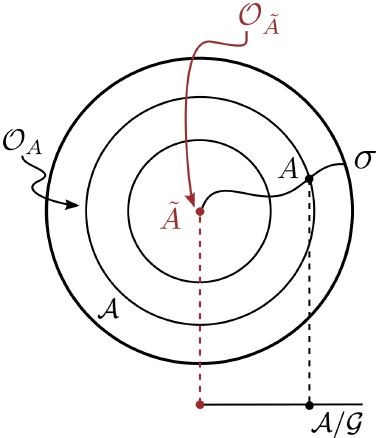
Figure 5: In this representation A is the page’s plane and the orbits are given by concentric circles. The field A is generic, and has a generic orbit, O . The field ˜ A has A a nontrivial stabilizer group (i.e. it has non-trivial reducibility parameters), and its is of a different dimension than O . The projection of ˜ A on A / G therefore orbit O ˜ A A sits at a qualitatively different point than that of A (a lower-dimensional stratum of A / G ). Exclusion of the reducible configuration ˜ A gives rise to a fibre bundle structure over A \ { ˜ A } ; here σ represents a section of A \ { ˜ A } . Locally, the concept of section can be generalized to include reducible configurations such as ˜ A , thus leading to the notion of “slice”. This is briefly reviewed in appendix